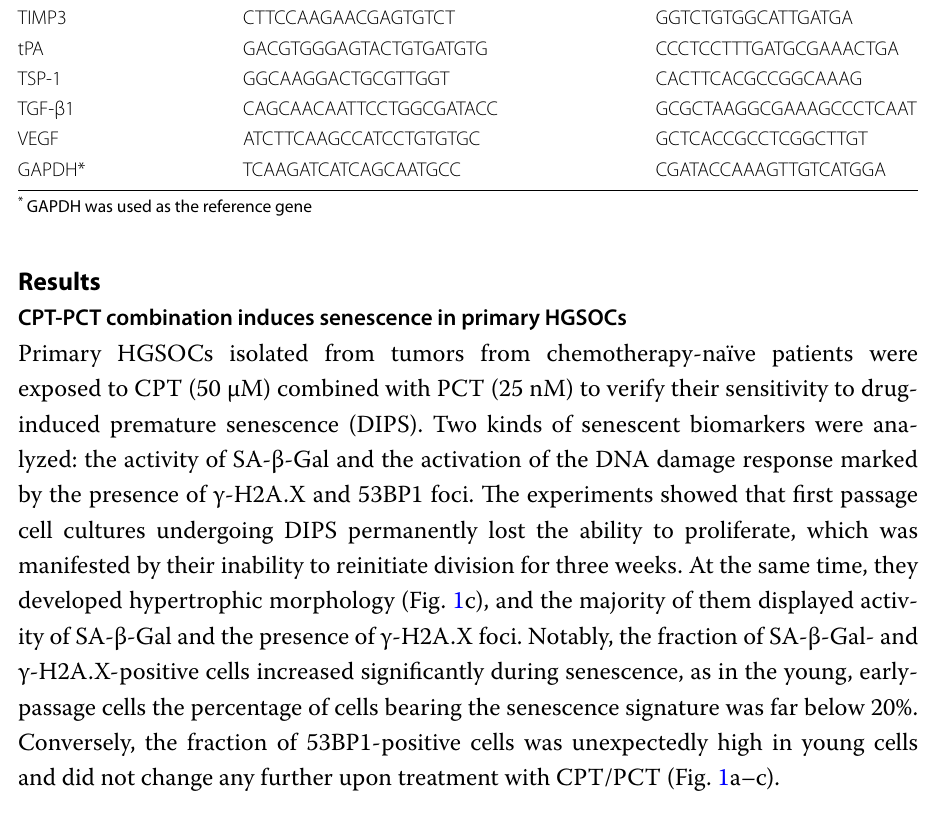
* GAPDH was used as the reference gene